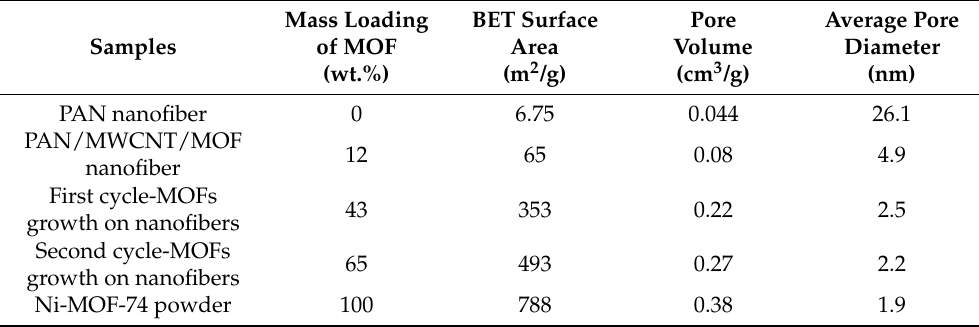
Table 5. Textural properties of neat PAN nanofiber, the first and second cycles of MOFs growth on the nanofibers and the MOF